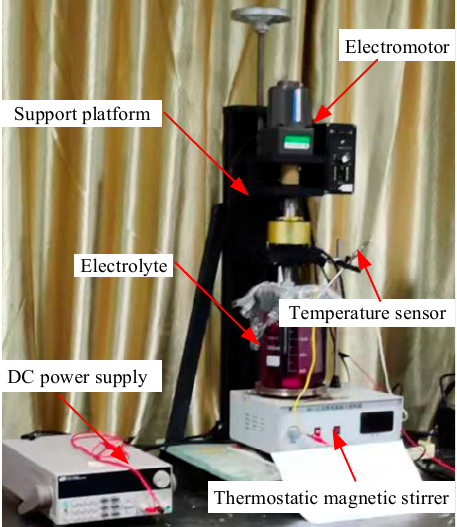
Figure 5. Experimental setup for the gold electroplating and copper electroforming.